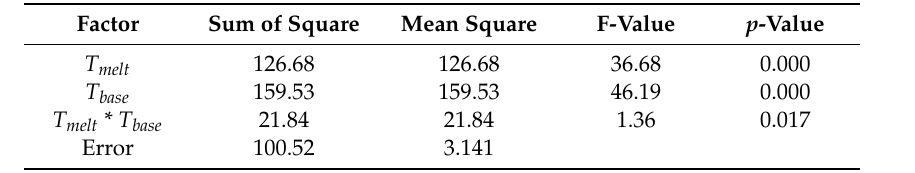
Table 4. ANOVA table for the e ff ect of the melt temperature and the base temperature on the bonding strength.